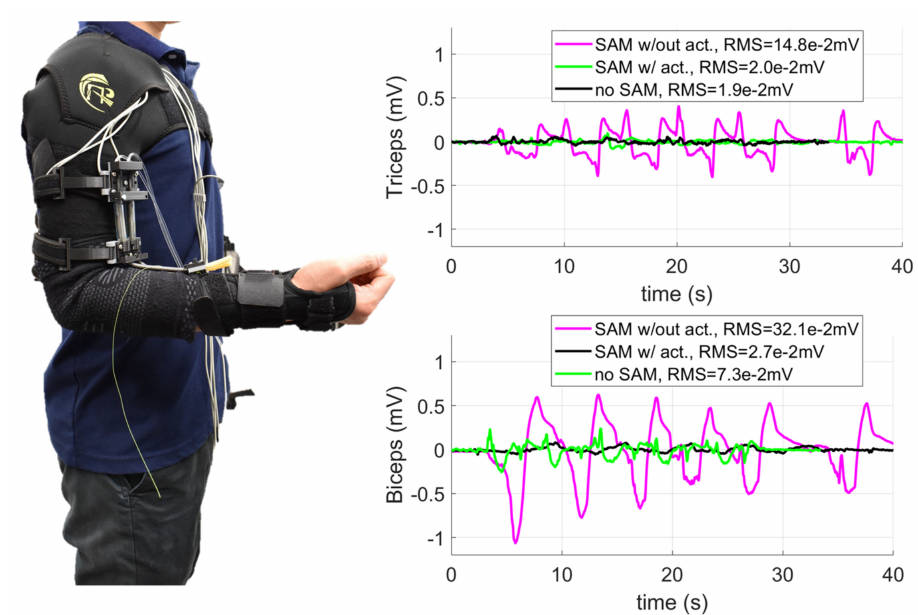
Figure 9. Validation of the soft robotic fabric sleeve for upper limb augmentation of a subject with EMG measurements and no load. ( Left panel ) Experimental setup for EMG measurements with no load. ( Right panel ) EMG measurements.